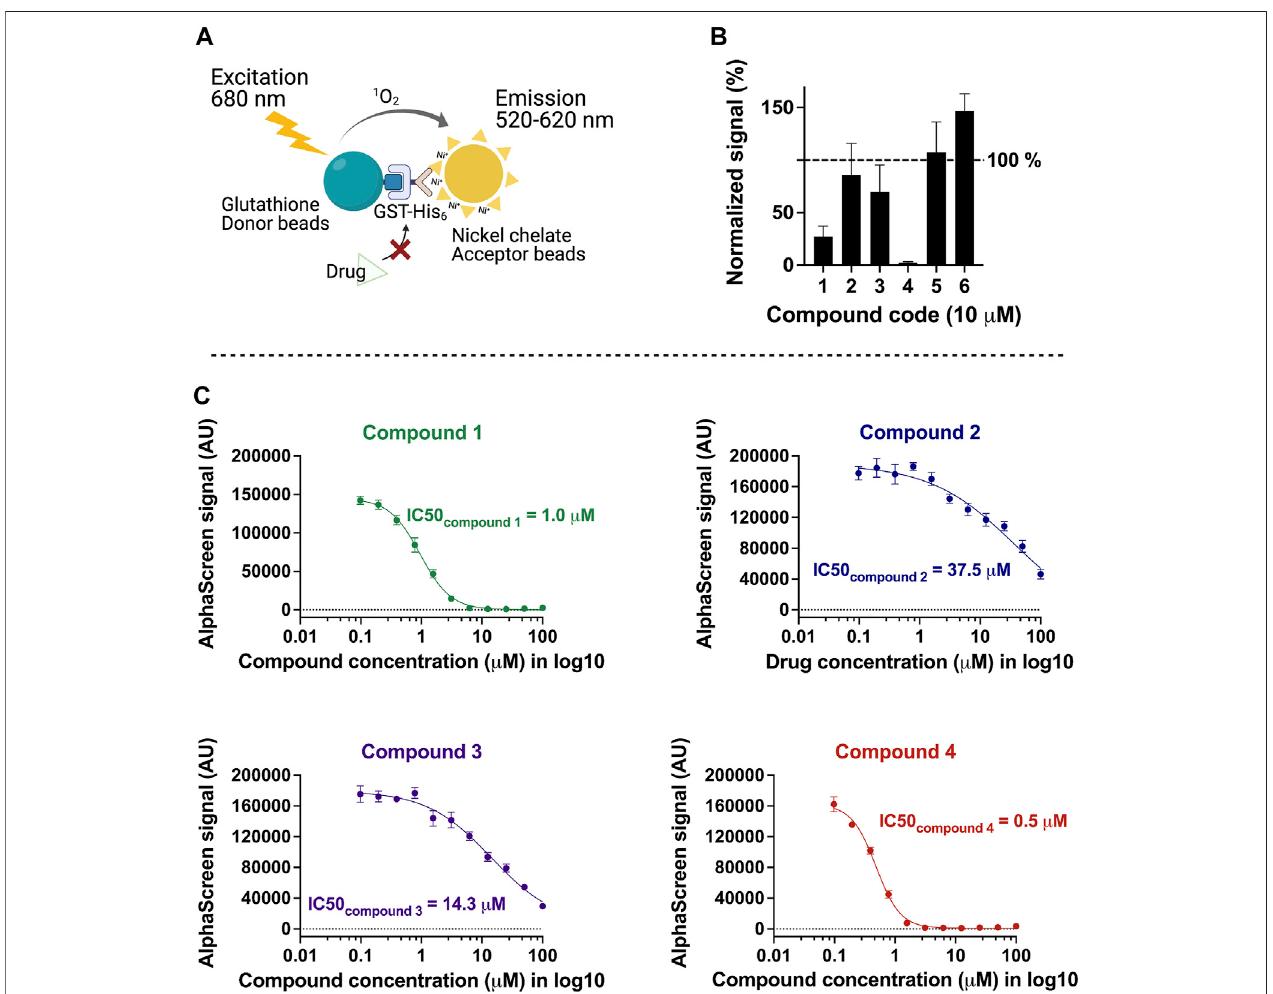
FIGURE2 | Characterization ofinhibitorswiththe counter screen assay and dose-dependent responseanalysis. (A) Recombinant GST-His wasused asacontrol toidentifycompoundsthatnon-speci fi callyreducetheAlphaScreensignal. (B) Normalizedlevelsofcompound-responseusingtest(signal TbPEX19-TbPEX3 )againstcontrol (signal GST-His ), 10 μ M of each compound was tested with TbPEX19 – TbPEX3 complex or GST-His, four of six candidates (compounds 1 , 2 , 3 , and 4 ) were selected for future analyses. (C) Dose-dependent response of the four compounds against TbPEX19 – TbPEX3 interaction. IC50 values of the four compounds are 0.5, 1.0, 14.3, and 37.5 µM for compounds 4 , 1 , 3 , and 2 , respectively.